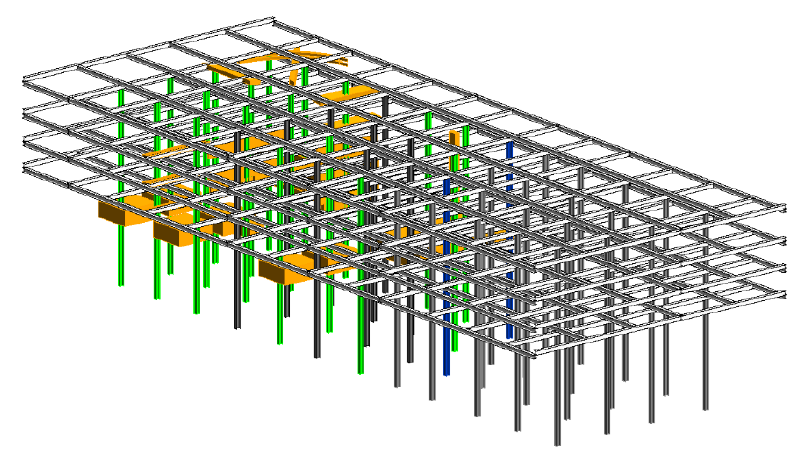
Figure 19. Clash detection of kingposts in a 3D environment.